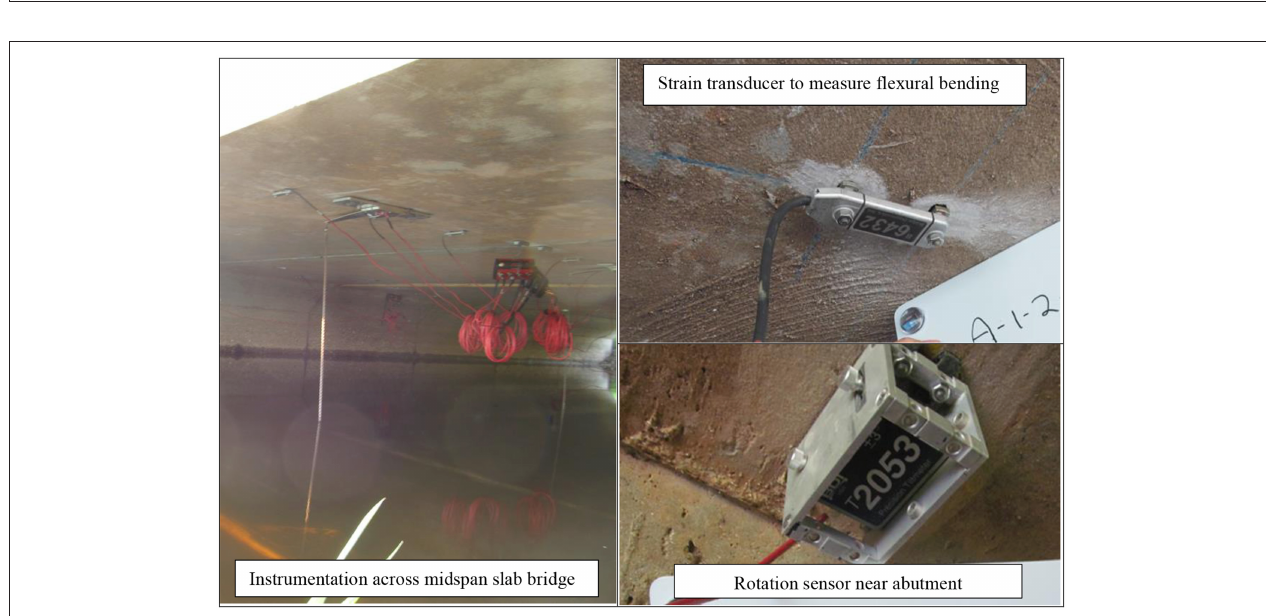
FIGURE 2 | Instrumentation to capture displacement, rotation, and flexural